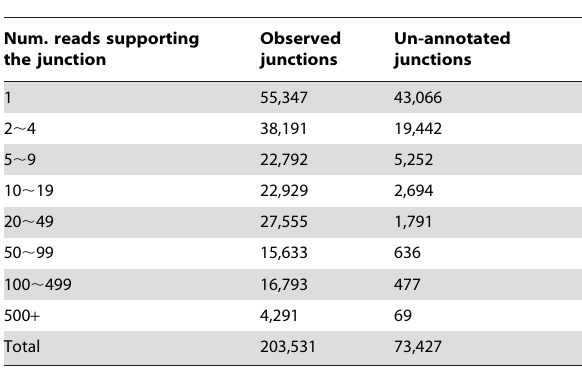
Table 1. Number of observed junctions from the RNA-Seq data and new findings not annotated in